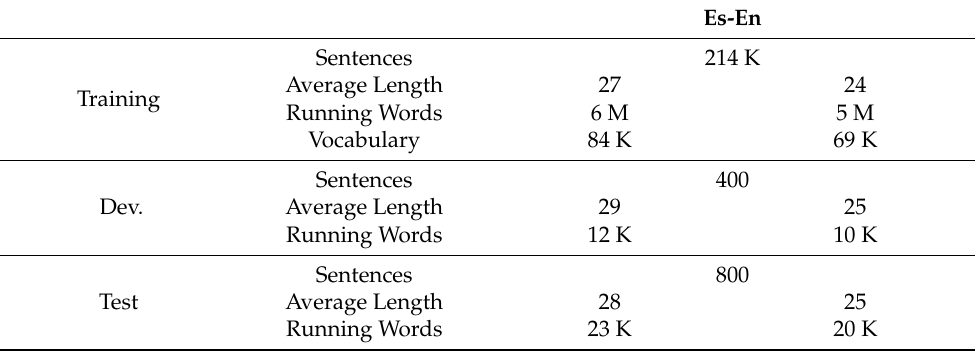
Table 1. Statistics of the Spanish–English EU corpus. K and M represent thousands and millions,